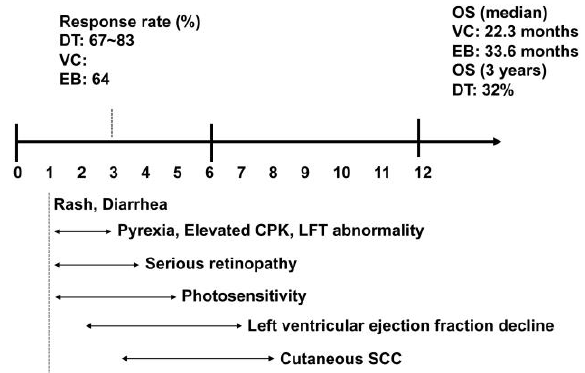
Figure 1. Efficacy and adverse events of combined therapy of BRAF inhibitors plus MEK inhibitors. Figure 1. E ffi cacy and adverse events of combined therapy of BRAF inhibitors plus MEK